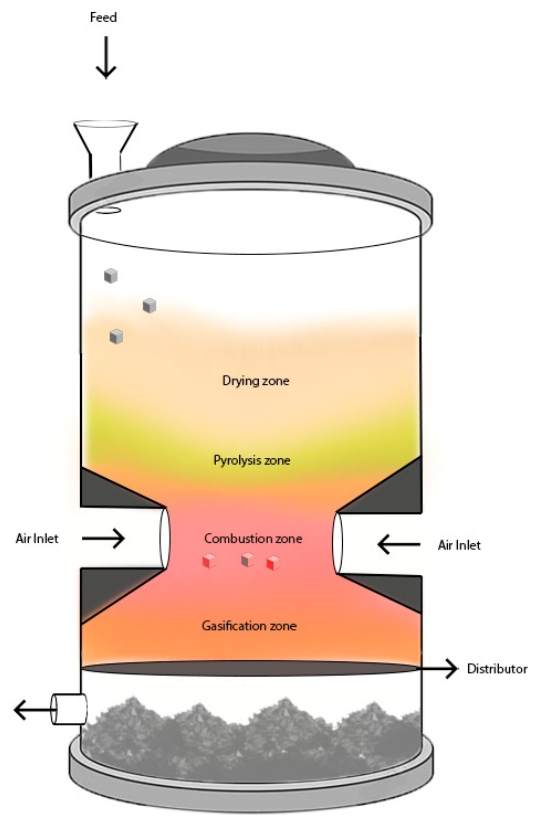
Figure 2. Downdraft or co-current gasifier.